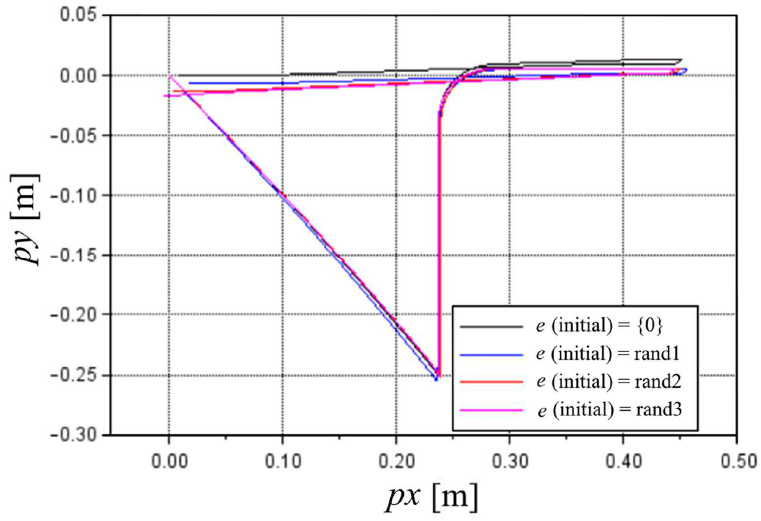
Figure 9. Nozzle route considering different optimized values of e . The first cycle of the 100% MS test.